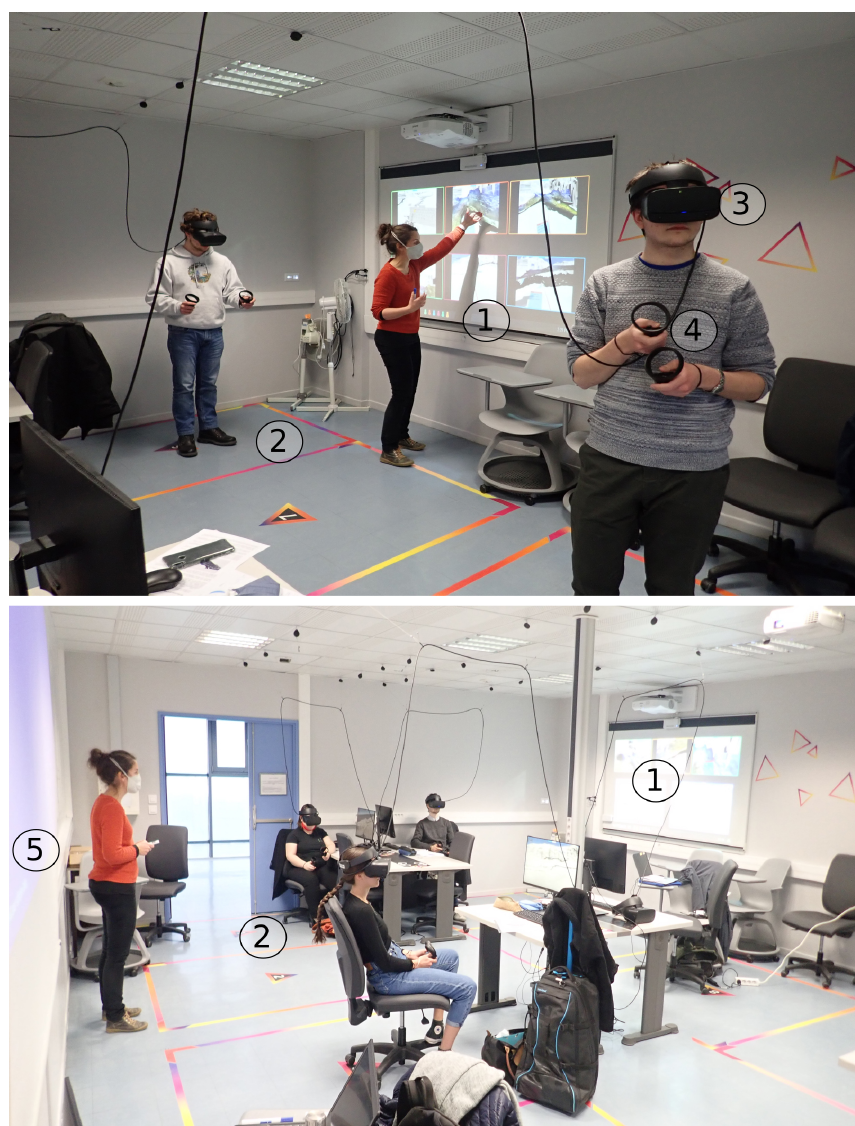
Figure 4. Views of virtual lab room in the alone in the field or single-user mode in which teacher (in orange) is outside the virtual environment. (1) Solstice collaborative screen-sharing system, (2) virtual box where limited real displacements of the user are allowed, (3) Oculus Rift S headset, (4) controllers, and (5) projection screen for teacher computer are all shown. It is worth noting that some students prefer to operate in VR while seated, while others find it more natural to be standing or moving within the limits of their virtual box